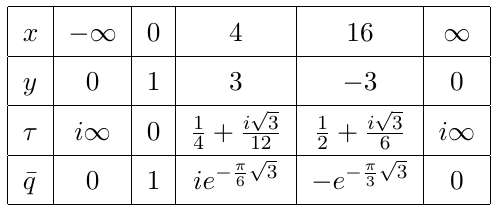
Table 1 . Correspondence between special values in x -space, y -space, τ -space and ¯ q -space.